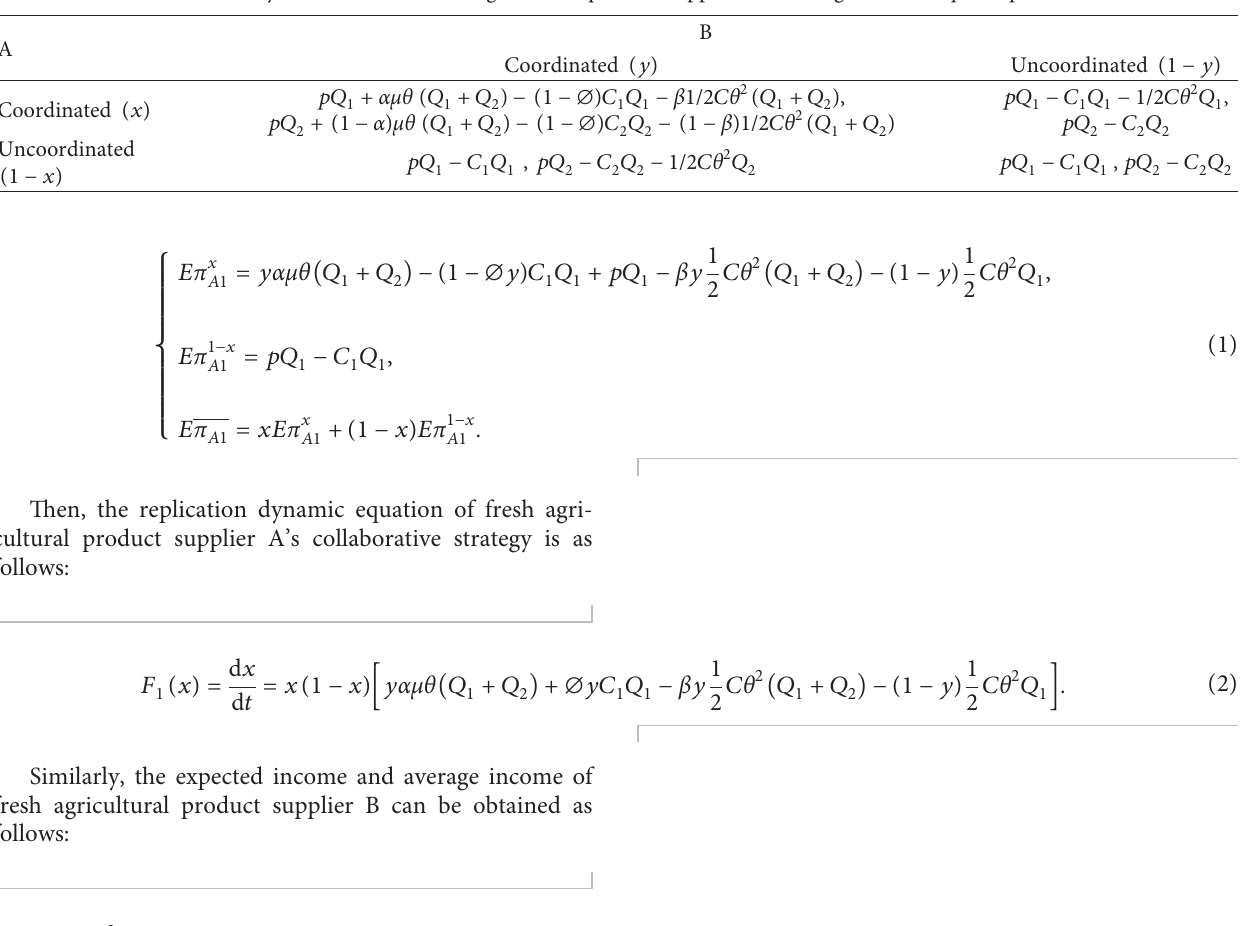
Table 1: Payment matrix of fresh agricultural product suppliers without government